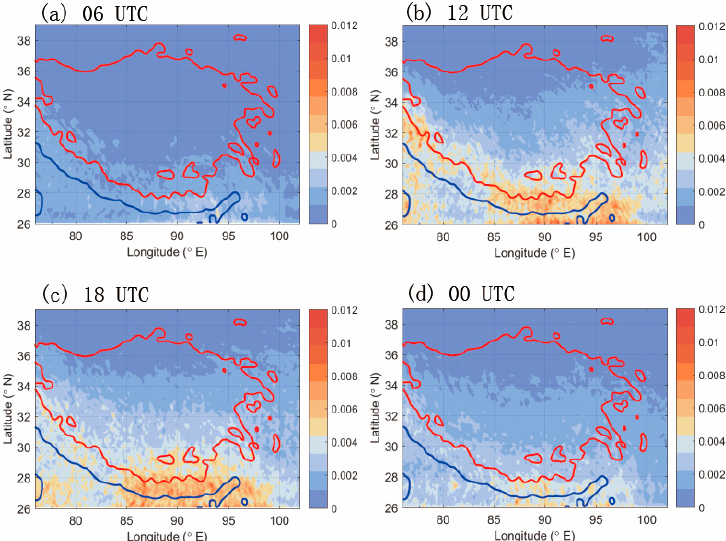
Figure 4. Geographic distribution of absolute horizontal momentum flux per unit volume (unit: Pa; shading, contour interval is 0.00109 Pa) at 30 hPa for 12-h forecast results at ( a ) 06 UTC (12 LT), ( b ) 12 UTC (18 LT), ( c ) 18 UTC (00 LT), and ( d ) 00 UTC (06 LT). The horizontal wavelength is taken from 10 km to 500 km. The red line represents the topography height at 4.5 km. The blue line represents the topography height at 0.3 km. Atmosphere 2020 , 11 , x FOR PEER REVIEW